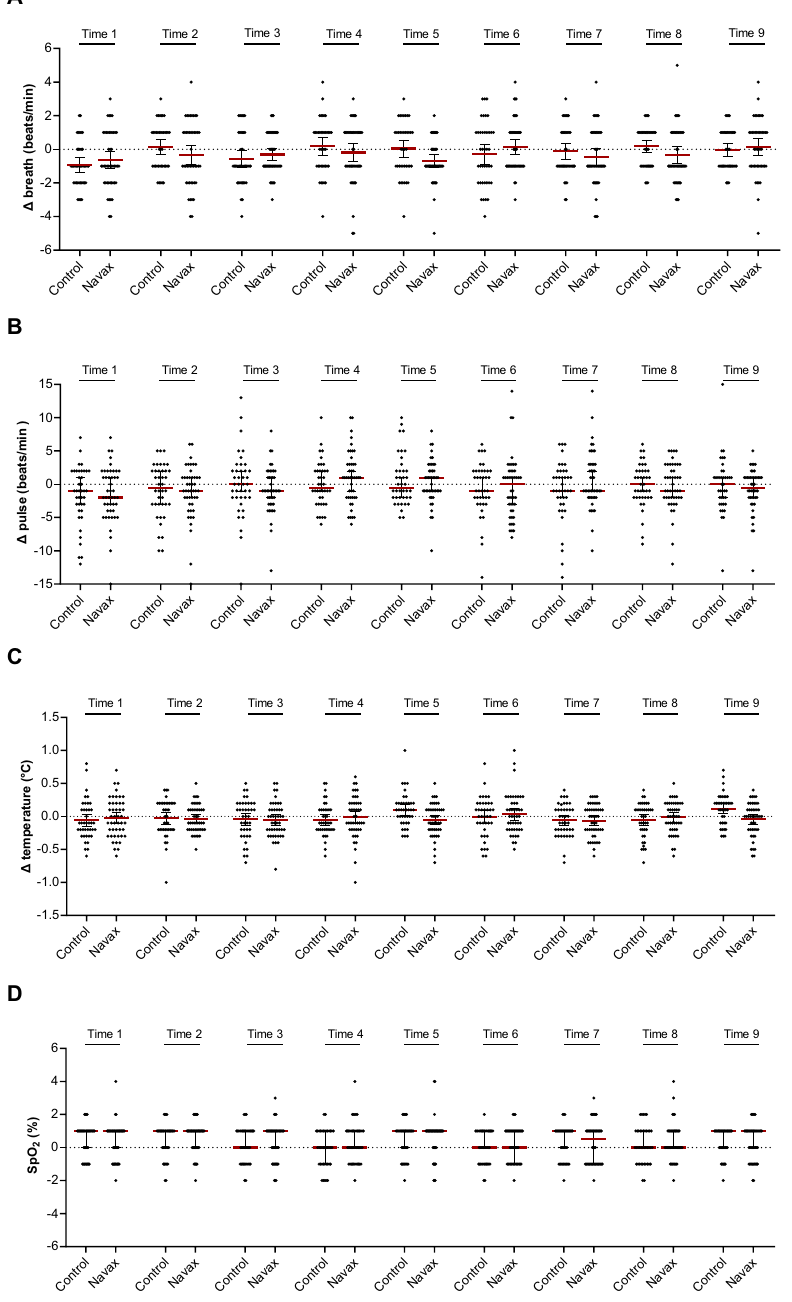
Figure 2. Average values of recorded changes in breath ( A ), pulse ( B ), temperature ( C ) and pulse oxygen ( D ) between before and after nasal-spraying with LiveSpo Navax (in diagonal-strip pattern) and 0.9% NaCl physiological saline (in white pattern), across 9 spraying times over 3